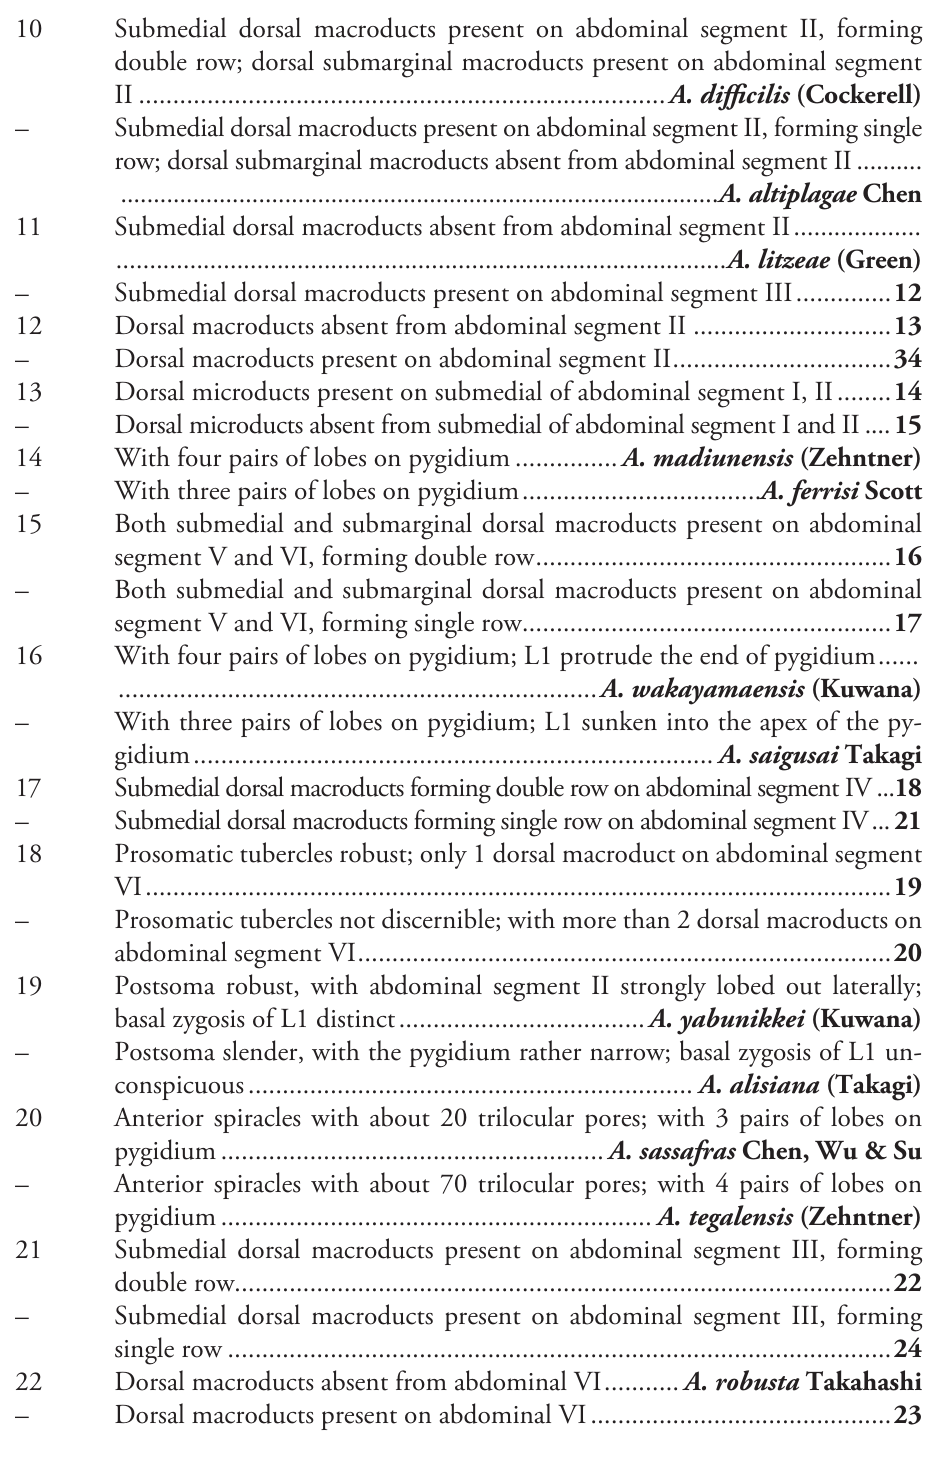
double row; dorsal submarginal macroducts present on abdominal segment